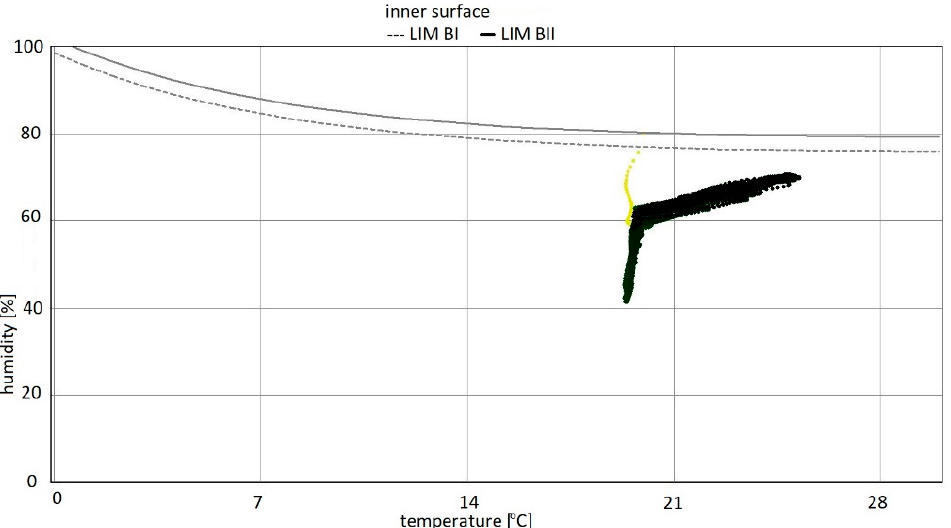
For variants 1–3 (Figures3–5), the moisture level for mineral wool during the ana- lysed period ranged from 1.7% to 4%, and for plasterboard from 0.44% to 0.80%. For these same variants 1–3, the humidity—temperature isopleth is presented in Figure 11. Figure 10. Changes in moisture content in plasterboard over eight years, variants 1–3 [70].